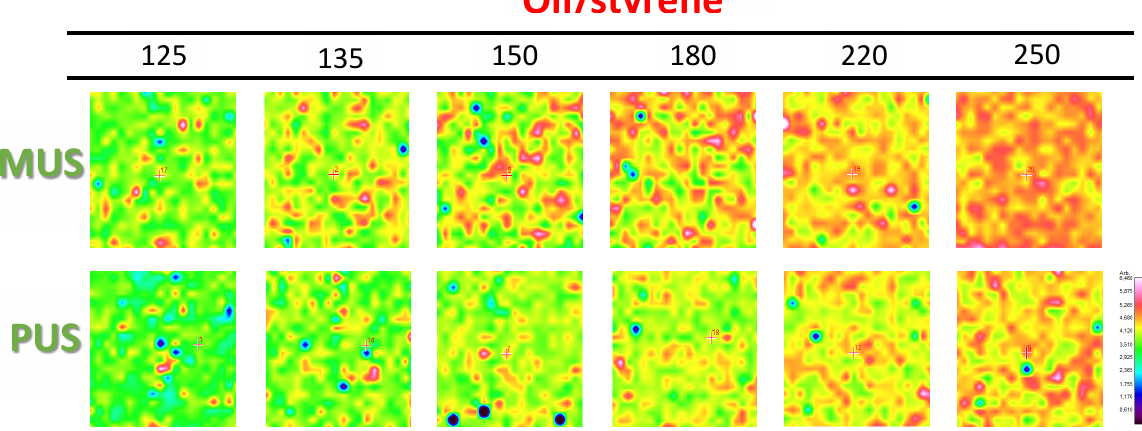
Figure 9. Raman spectroscopy surface maps of SMI/SfO-MUS and SMI/SfO-PUS coatings (1 × 1 mm 2 ), representing band intensity ratio of oil/styrene (same intensity scale for all